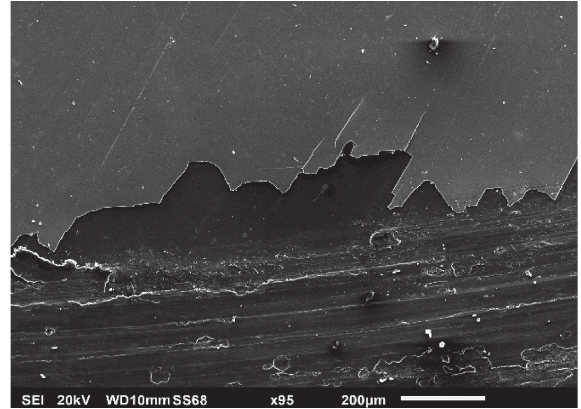
Figure 7: Photograph of thin film detachment around the abrasion test track (90 ′ sputtered specimen, 16 ∗ ).